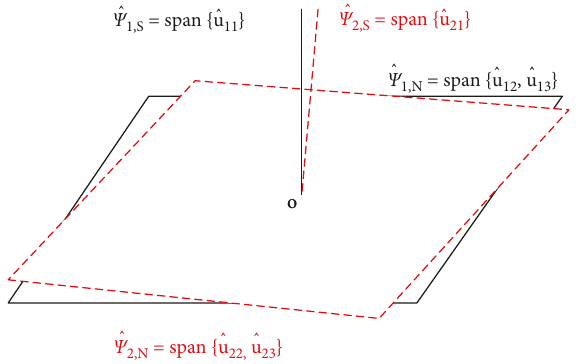
Figure 7: Diagram of the three-dimensional geometric